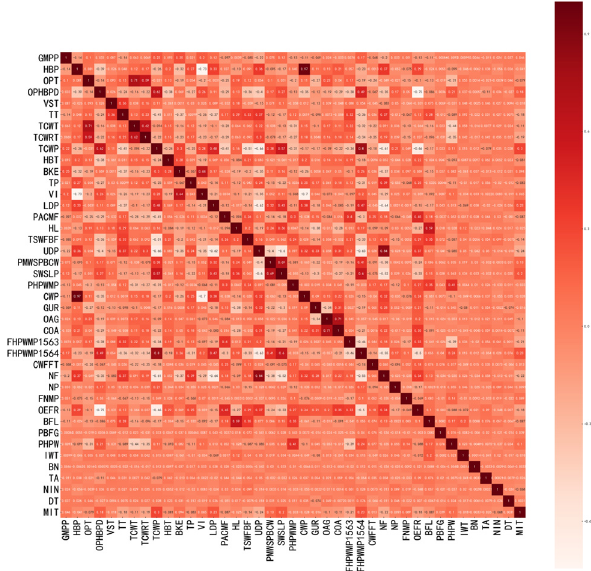
Figure 2: Heatmap of Pearson correlation coe ffi cient.